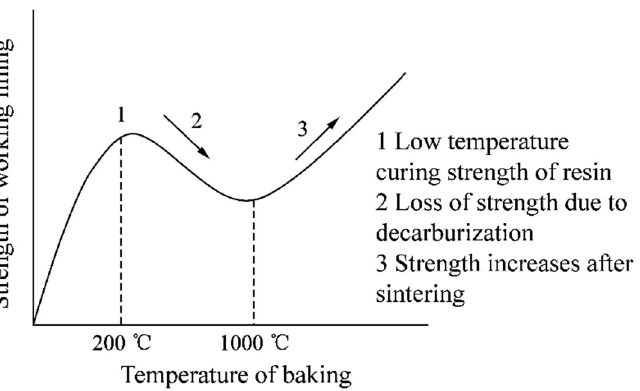
Figure 9. Strength characteristics of the dry vibrating material of the working layer